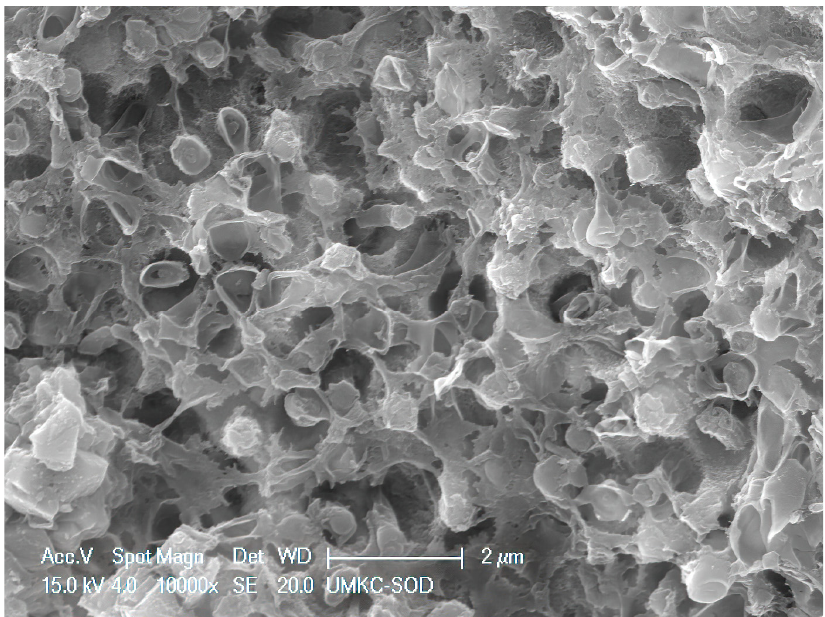
Figure 6. SRP + EDTA-treated specimen. High magnification view of a dense aggregate of coccoid bacteria showing the effect of the EDTA. Many of the microbes appear to have ruptured. Additionally, note the loss of extracellular matrix. Original magnification of 5000×; Bar = 5 μ m.